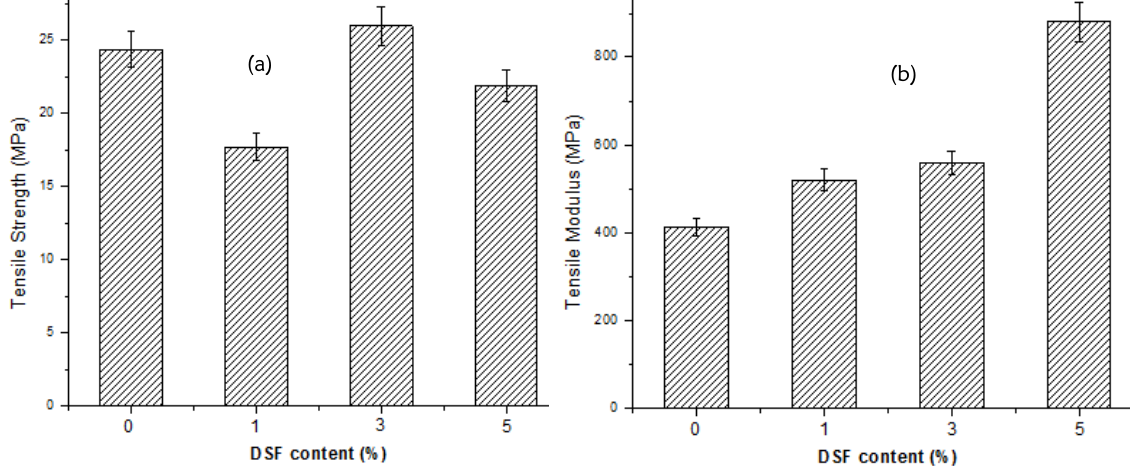
Figure 2: Effect of DSF content of PLA composites on (a) tensile strength (b) tensile modulus